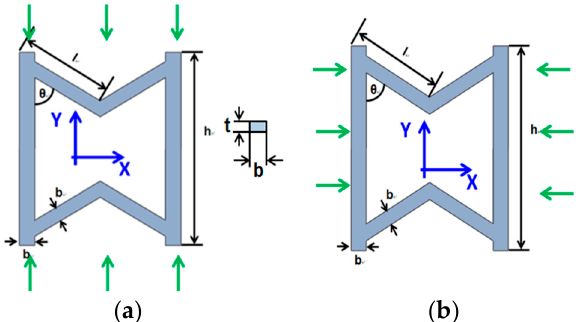
Figure 11. ( a ) Load force of stent unit cell in x -direction; ( b ) load force of stent unit cell in x -direction.